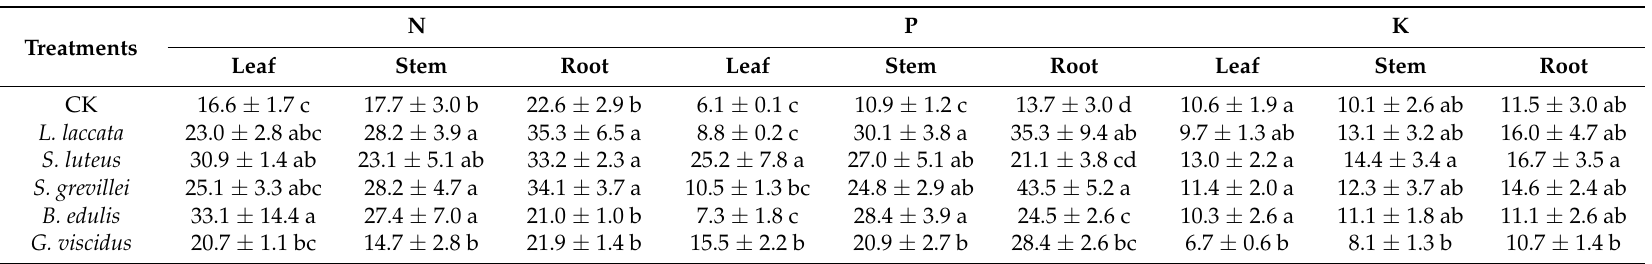
Table 3. Nutrient content (mg/pot) in the leaves, stems, and roots of Pinus tabuliformis seedlings: L. laccata , S. luteus , S. grevillei , B. edulis G. viscidus , and treated with sterilized substance (CK) (mean ±